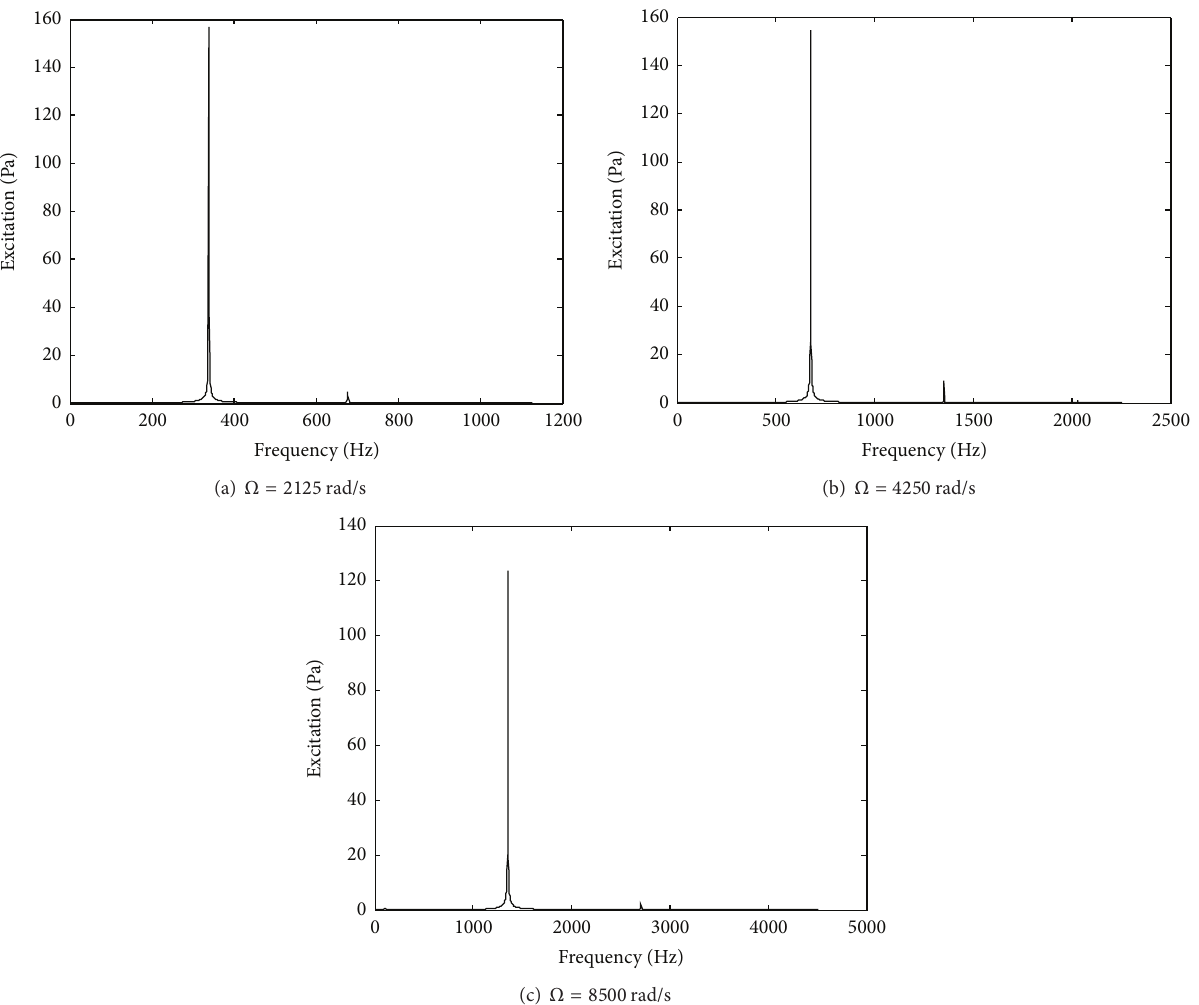
Figure 17: Calculation results of airflow exciting force on the rotor rim surface of Rampressor inlet in different rotor whirling frequencies.